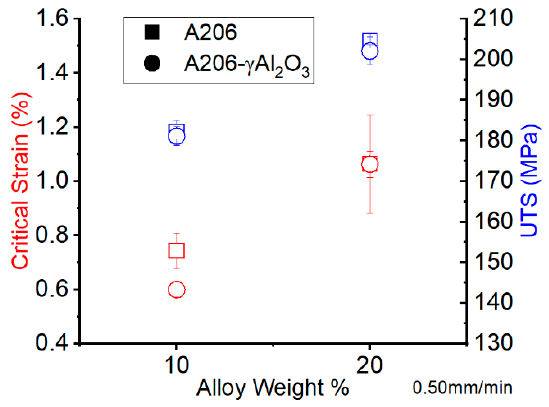
Figure 4. Measured critical strain and UTS at a 0.500 mm/min strain rate.